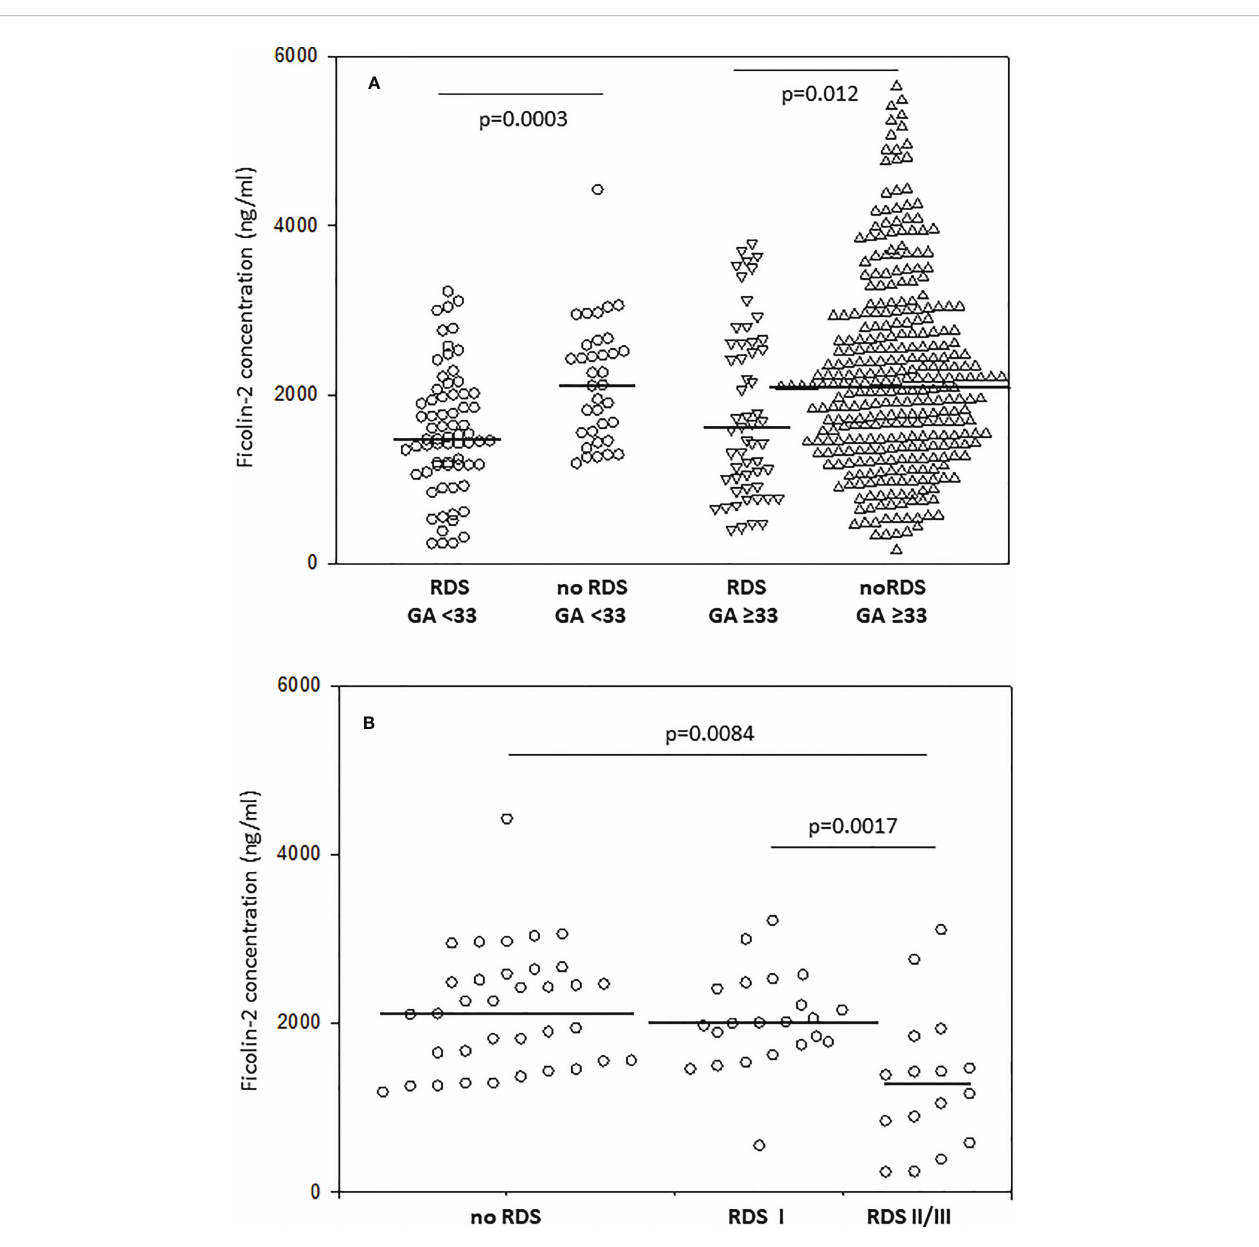
FIGURE 1 The comparison of fi colin-2 cord blood serum concentration in preterm neonates with and without respiratory distress syndrome (RDS), depending on gestational age (A) and disease severity in neonates delivered at GA <33 (B) . The horizontal lines mark median values. Medians were compared with the use of Mann-Whitney U test (A) and Kruskal-Wallis test (p=0.015) with post-hoc Dunn test (B)